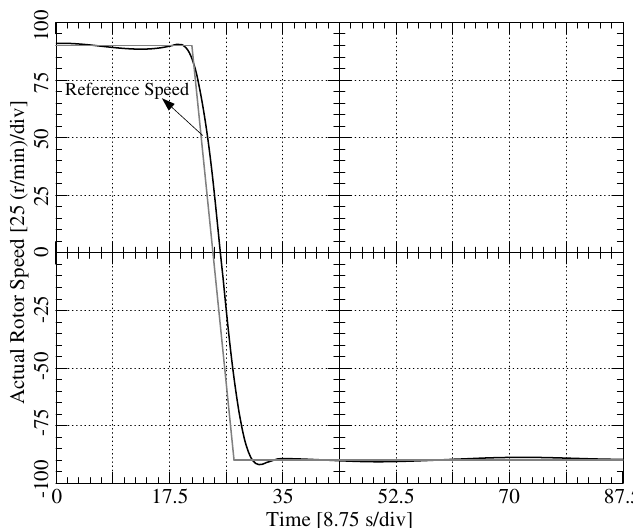
Figure 16. Experimental transient speed reversal test ( ± 90 r/min) under full load (2 N·m) with K = 5 (high) while R s is increased by 82.35% and λ f is decreased by 40% of its original value.